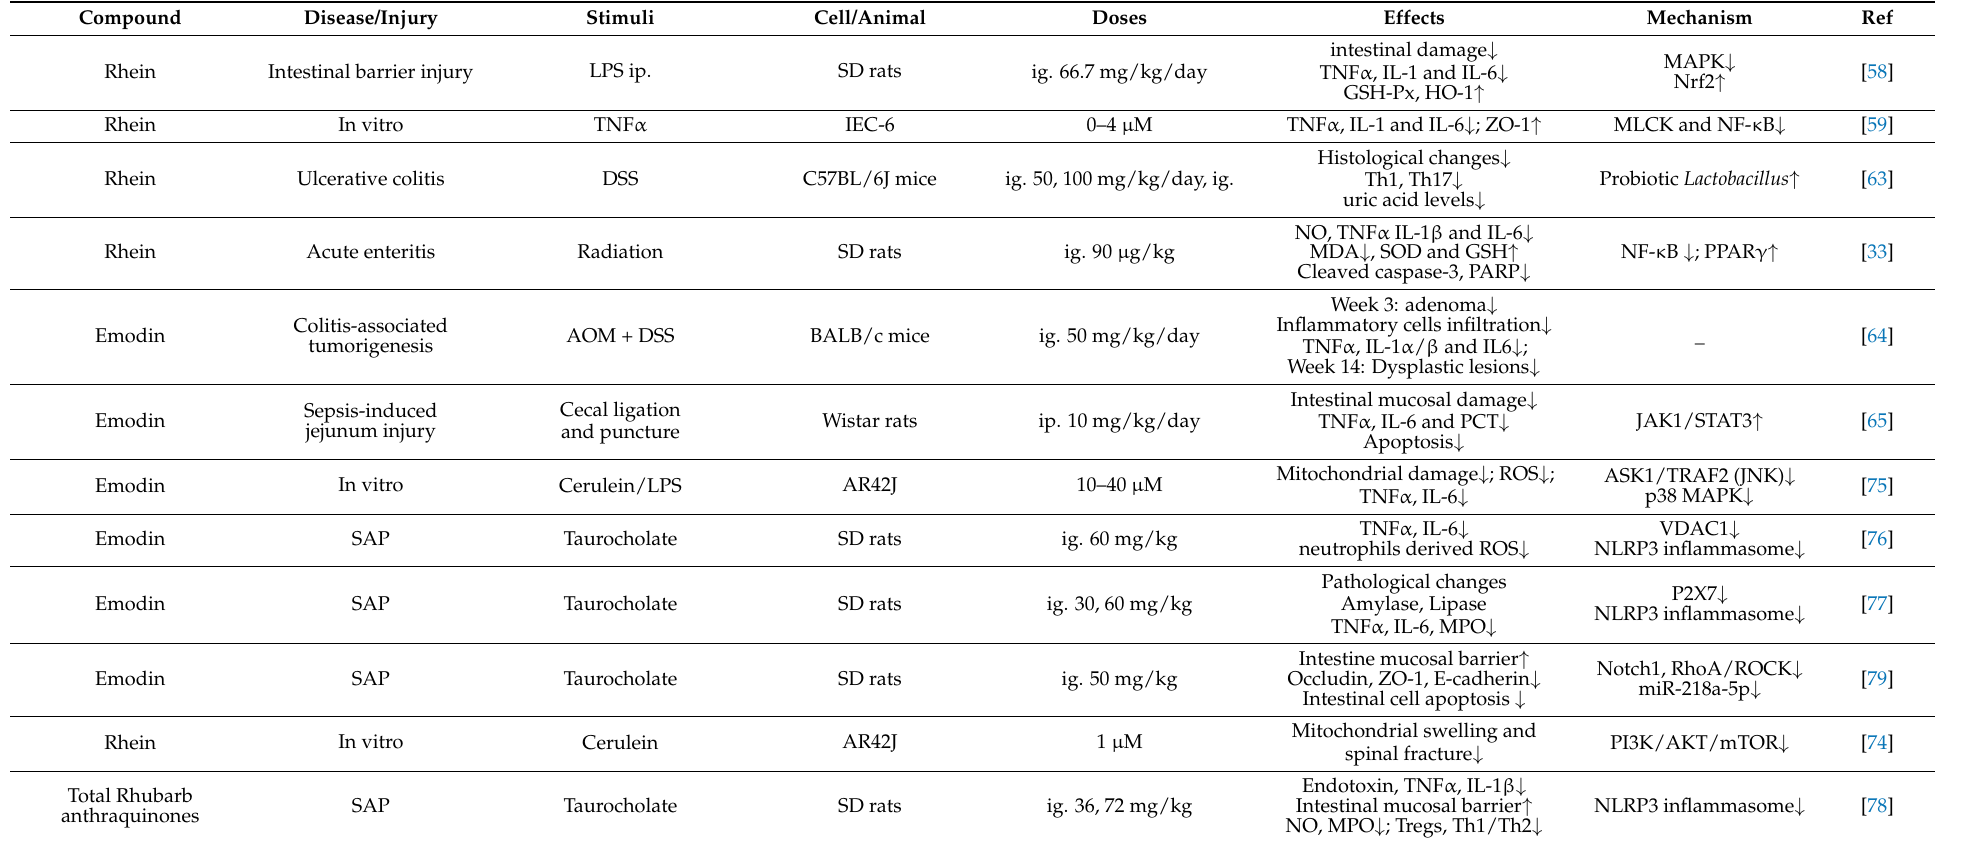
Table 2. Effects and mechanism of AQs on digestive